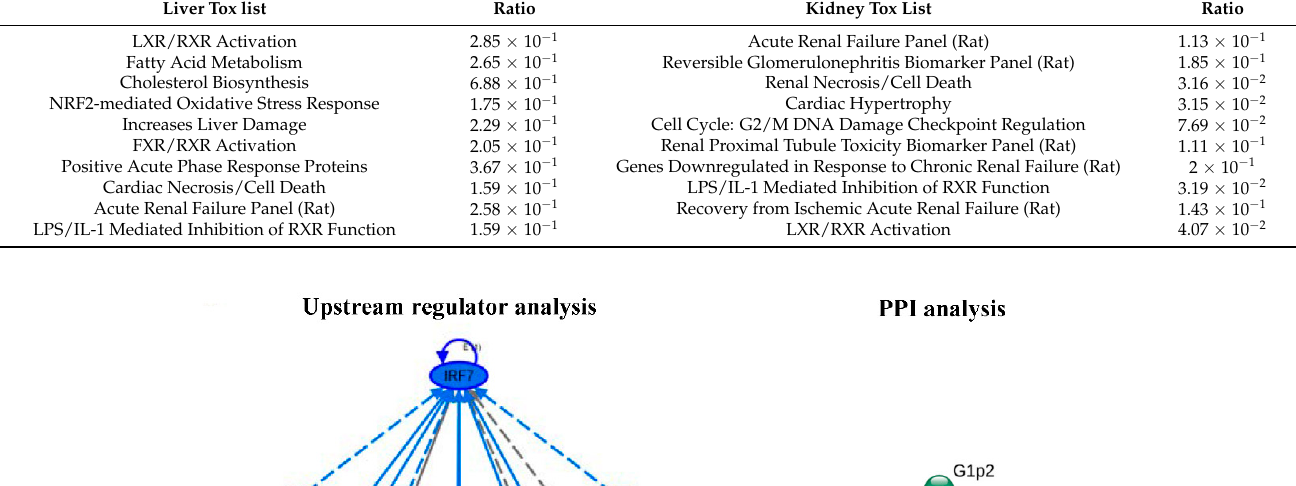
Table 8. Tox-list analysis result associated with 1 week of consecutive ifosfamide (100 mg/kg) treatment. Table 7. Biological function list of differentially expressed genes from ifosfamide-treated liver and kidney.